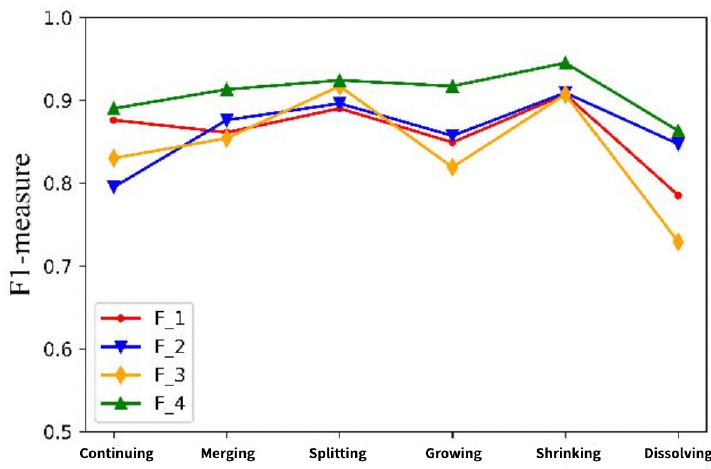
Figure 8. Hepth dataset prediction